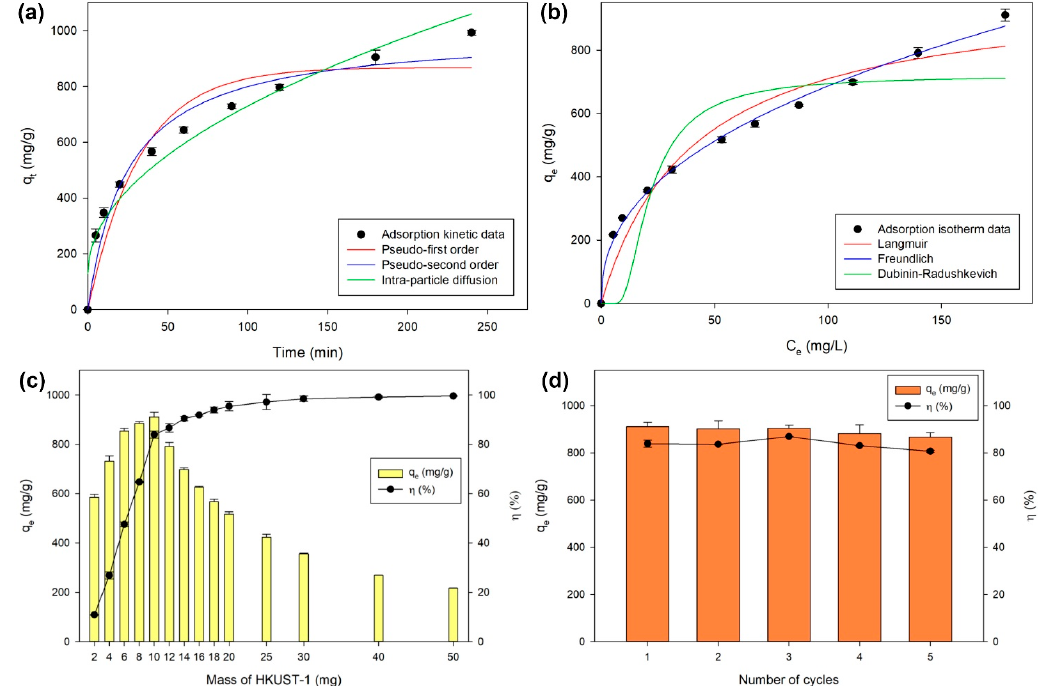
Figure 8. ( a ) Non-linear adsorption isotherms of CV dye onto HKUST-1, ( b ) non-linear adsorption kinetics of CV dye onto HKUST-1, ( c ) adsorption capacity and removal efficiency of HKUST-1, and ( d ) Reusability of HKUST-1. Table 5. Adsorption kinetic modelling constants of CV dye adsorption onto HKUST-1.